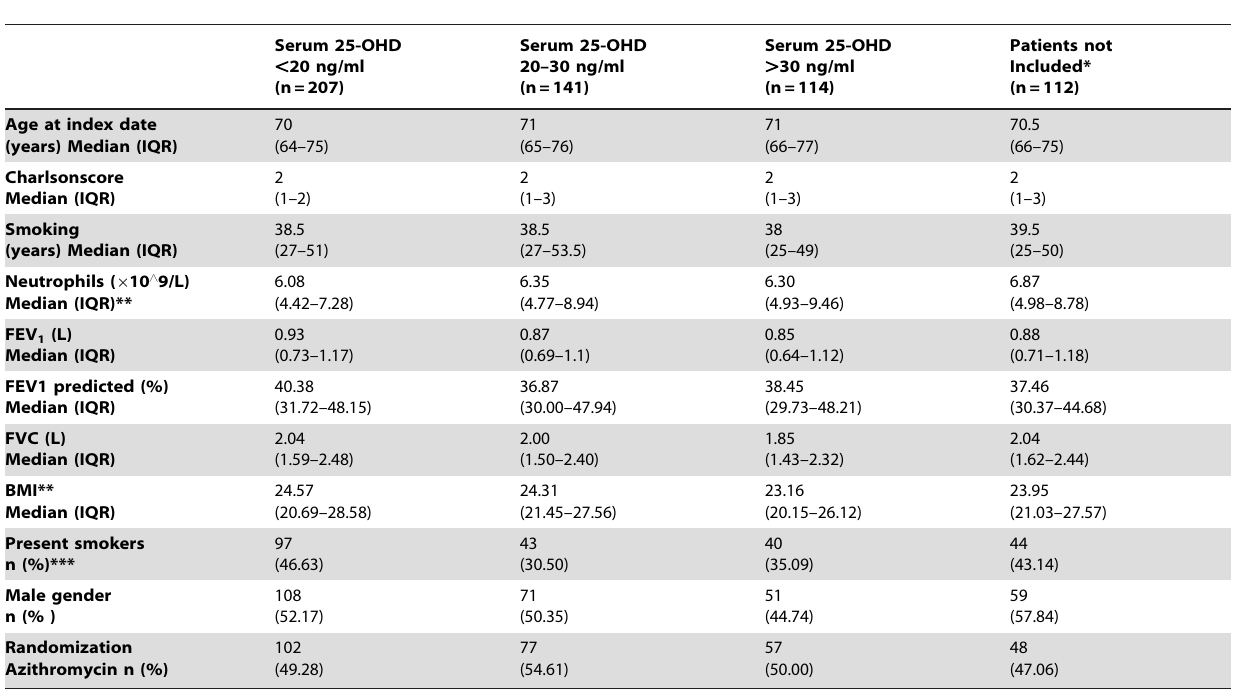
Table 1. Distribution of baseline characteristics based on conventional 25-OHD